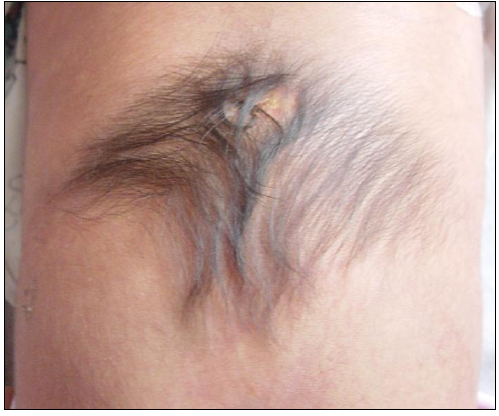
Figure 1: Note hypertrichiosis (Faun tail) with a patch of aplasia cutis congenital and dermal sinus tract.